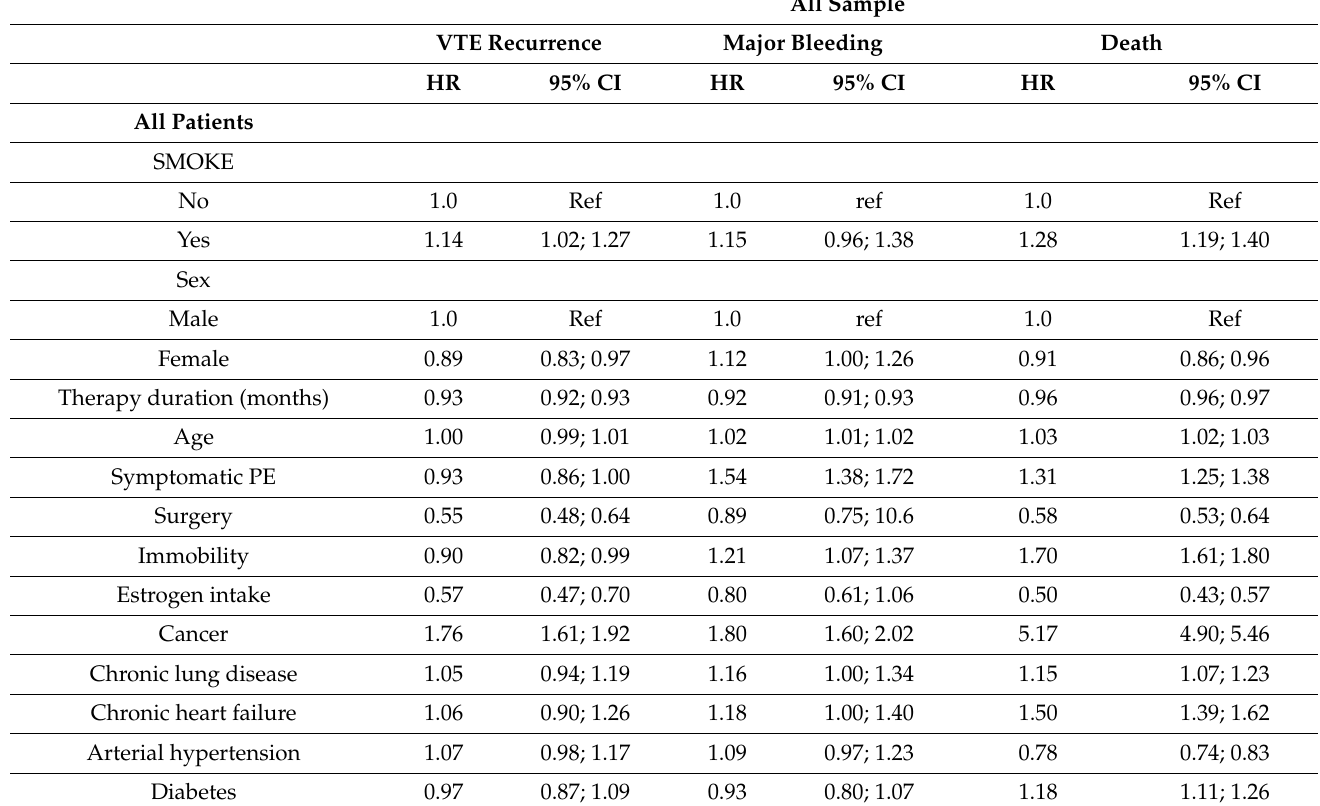
Legend to Table 3: HR, hazard ratio; CI, confidence intervals; PE, pulmonary embolism; CrCl, creatinine clearance; DVT, deep vein thrombosis; Ref., reference. Table 4. Multivariate analyses for all-cause mortality, VTE recurrences, and major bleeding in patients with or without cancer. Results are expressed as hazard ratio and 95% confidence